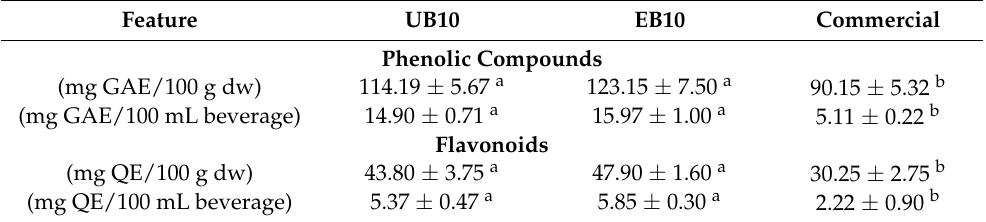
Table 2. Total phytochemical content of unprocessed and extruded sesame seeds byproduct flour beverages, and commercial beverage.